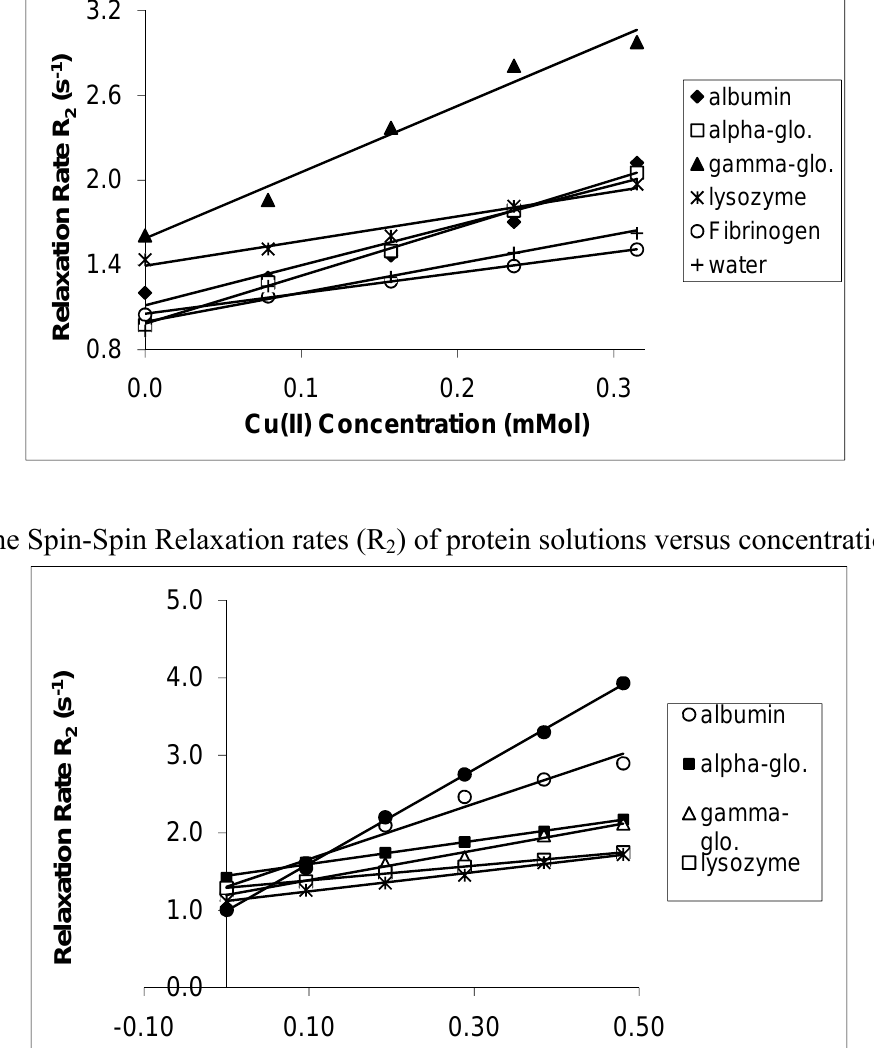
) of protein solutions versus concentration of Cu(II) 2